Question: Briefly state, in one sentence, what is plotted here.
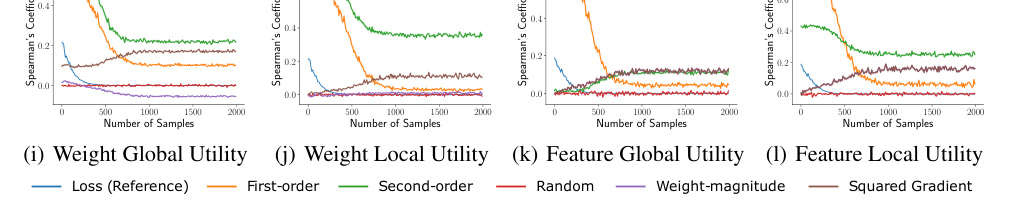
Answer: Spearman correlation between the true utility and approximated utilities. The activations used in the first, second, and third rows are ReLU, LeakyReLU, and Tanh. The shaded area repre- sents the standard error.